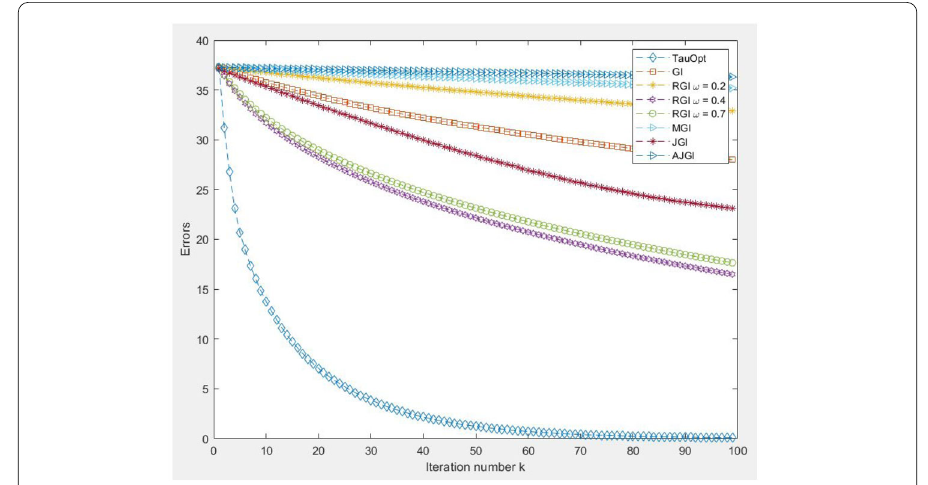
Figure 2 Errors for Example 5.2